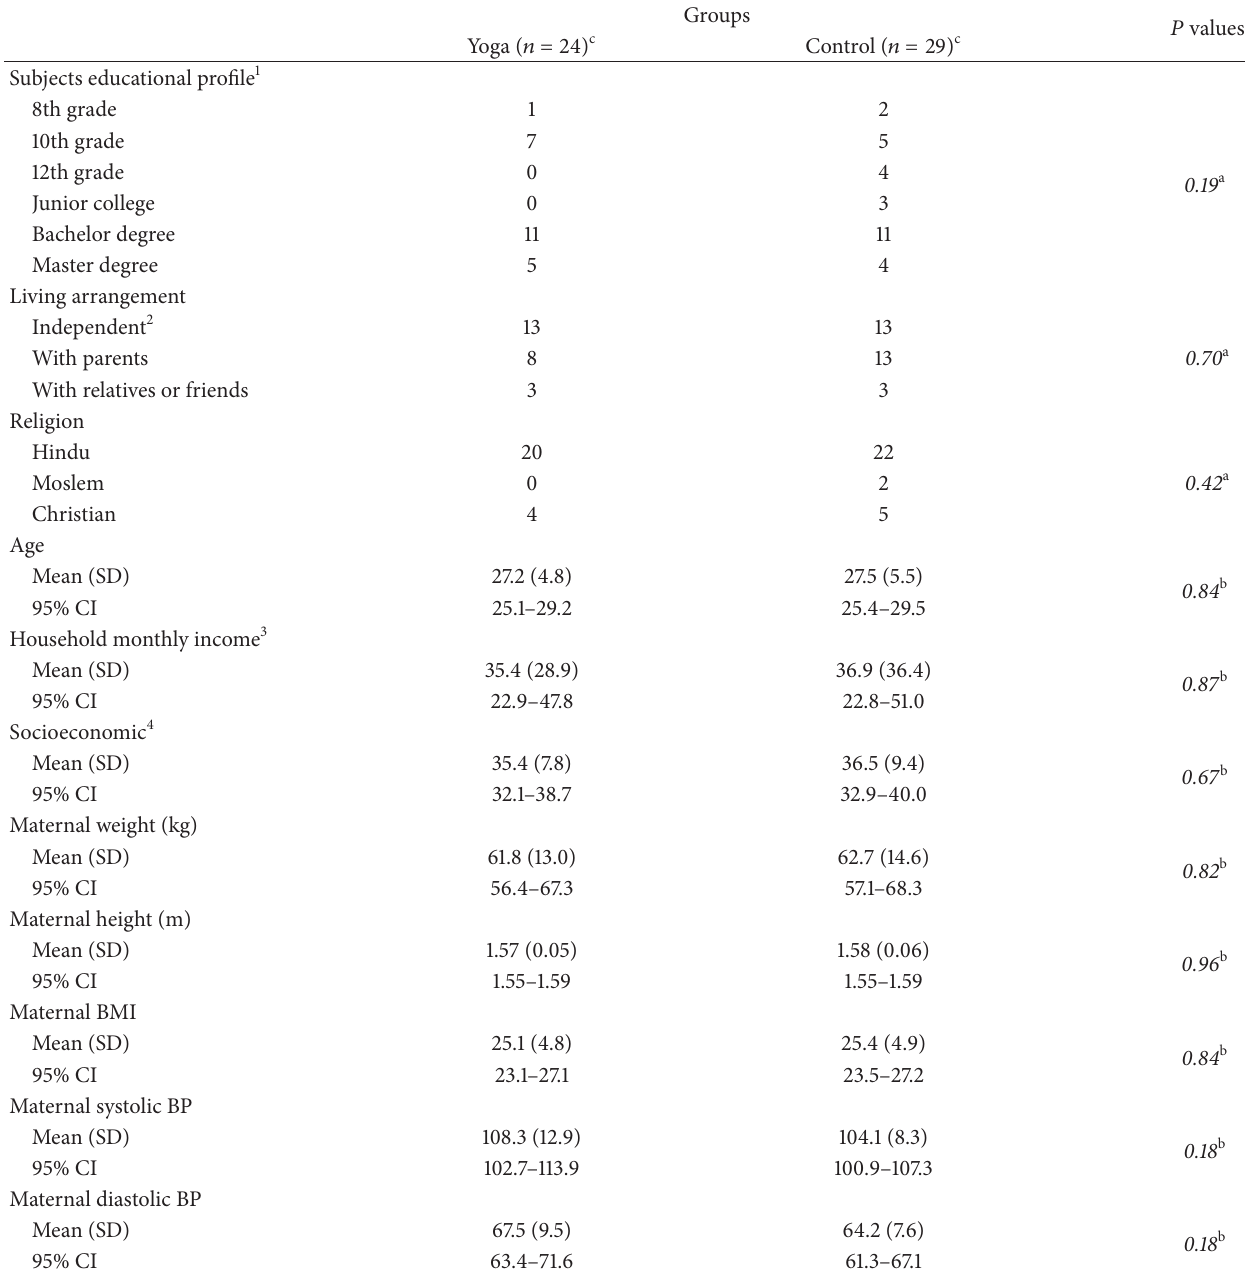
Table 2: Demographic data and maternal characteristics at baseline.